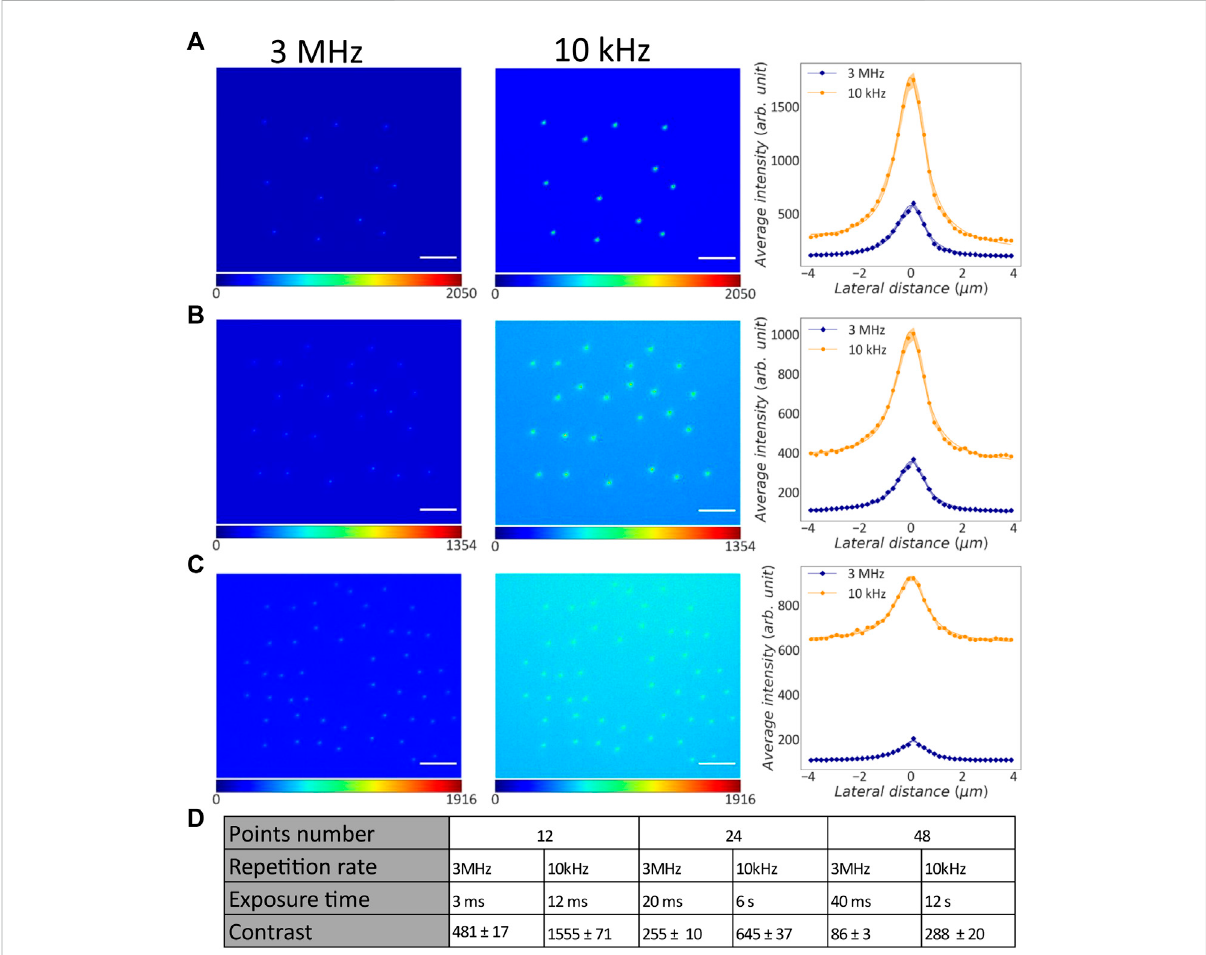
FIGURE 3 Comparison between point-cloud CGHs projected into liquid fl uorescein with different repetition rates. (A) Left: TPEF image of 12-point CGH projected with 3 MHz repetition rate. Middle: TPEF image of the same CGH projected with 10 kHz repetition rate. Scale bar: 25 μ m. Right: Average line pro fi les across the pixel of maximumintensity for all the points projected with 3 MHz (blue rhombuses) and 10 kHz (orange dots) repetition rate. Continuous lines: Lorentzian fi t on the data points; shadow areas: s.e.m.; orange: 10 kHz; blue: 3 MHz. (B) Left: TPEF image of 24-point CGH projected with 3 MHz repetition rate. Middle: TPEF image of the same CGH projected with 10 kHz repetition rate. Right: Average line pro fi les across the pixel of maximum intensity for all the points projected with 3 MHz (blue rhombuses) and 10 kHz (orange dots) repetition rate. Continuous lines: Lorentzian fi t on the data points; shadow areas: s.e.m.; orange: 10 kHz; blue: 3 MHz. (C) Left: TPEF image of 48-point CGH projected with 3 MHz repetition rate. This image was enhanced with a gamma factor of 1.2 for visualization. Middle: TPEF image of the same CGH projected with 10 kHz repetitionrate.Right:Averagelinepro fi lesacrossthepixelofmaximumintensityforallthepointsprojectedwith3 MHz(bluerhombuses)and10 kHz (orange dots) repetition rate. Continuous lines: Lorentzian fi t on the data points; shadow areas: s.e.m.; orange: 10 kHz; blue: 3 MHz. (D) Table with experimental parameters used to acquire each grid image, contrast and corresponding